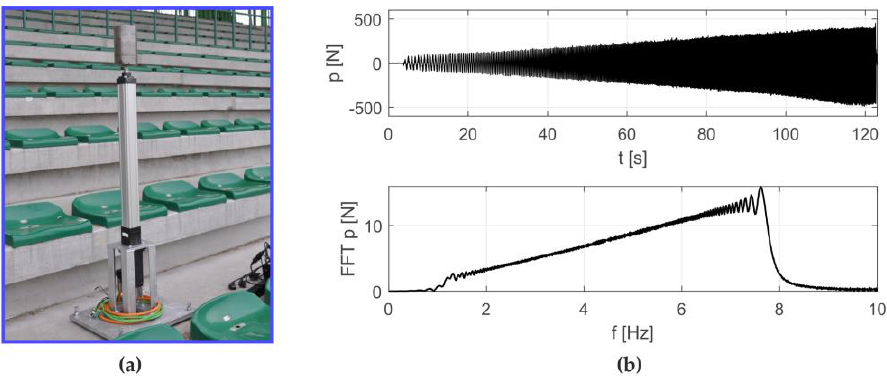
Figure 5. Experimental setup: ( a ) electromechanical actuator, ( b ) excitation signal in the time and frequency domains.